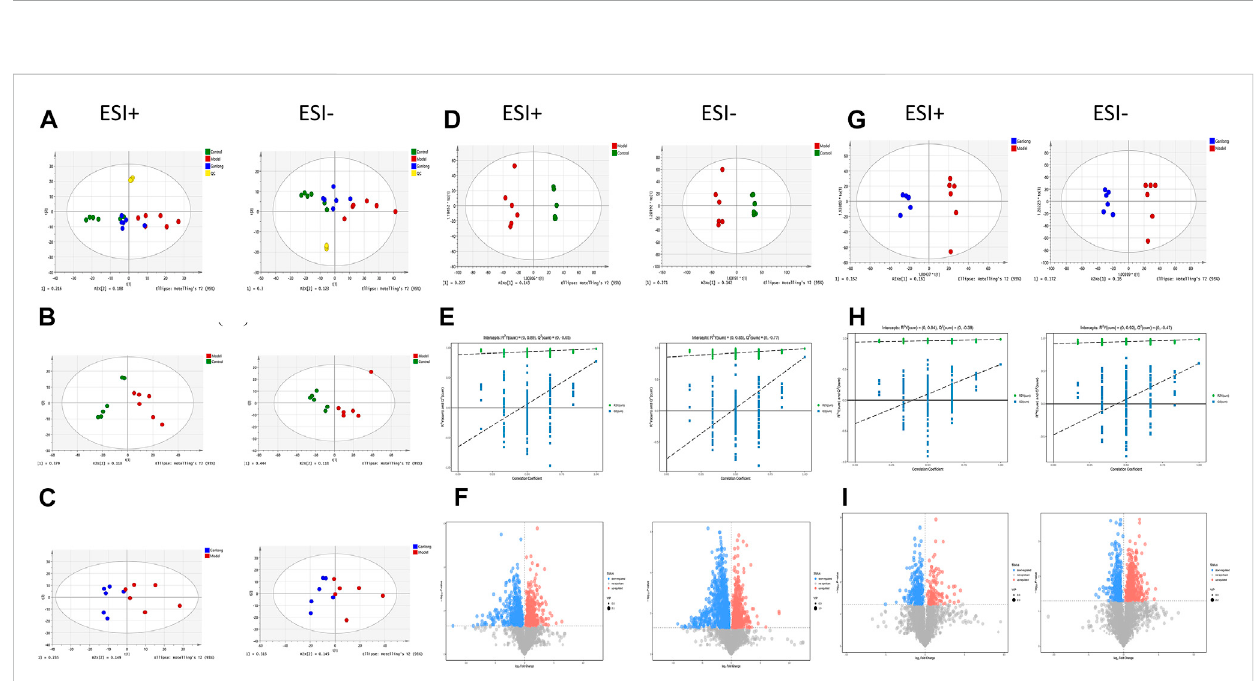
FIGURE 4 Metabolomic analysis ofliver tissues ofrats with liver fi brosis byGanlong capsules. (A) Plotsof liver tissue PCAscores between positive and negative ionnormalcontrolgroup,Ganlongcapsulegroupandmodelgrouprats. (B) PCAplotsoflivertissuesbetweenmodelgroupvs.normalcontrolgroupand (C) Ganlongcapsulegroupvs.modelgroupratsinpositive andnegativeionmode. (D – F) PlotsofOPLS-DAscores,200thresponserankingtestplotsand volcano plots between normal control and model groups in positive and negative ion mode. (G – I) Plots of OPLS-DA scores, 200 response sorting test plots and volcanoes between the model and Ganlong capsule groups in positive and negative ion mode. Control group, model group and Ganlong capsule treatment group ( n = 6).